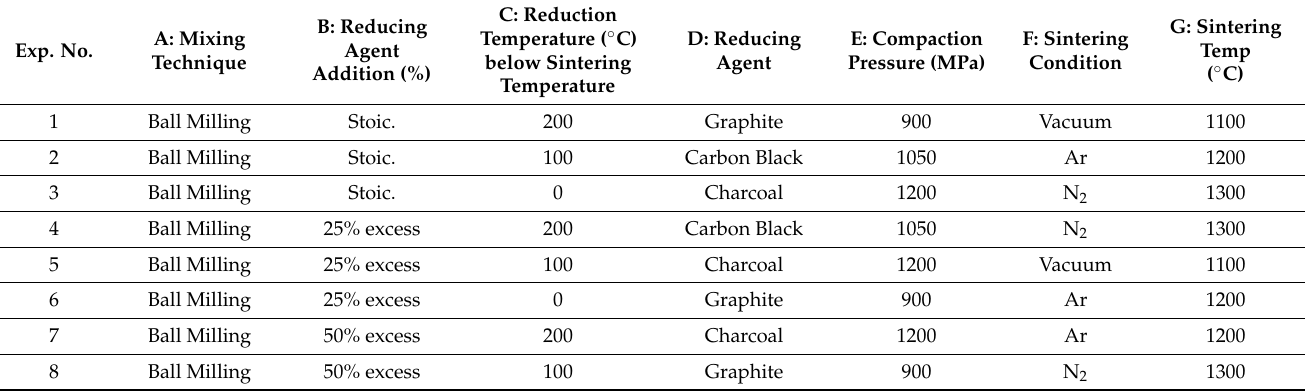
Table A1. Experimental conditions for L27